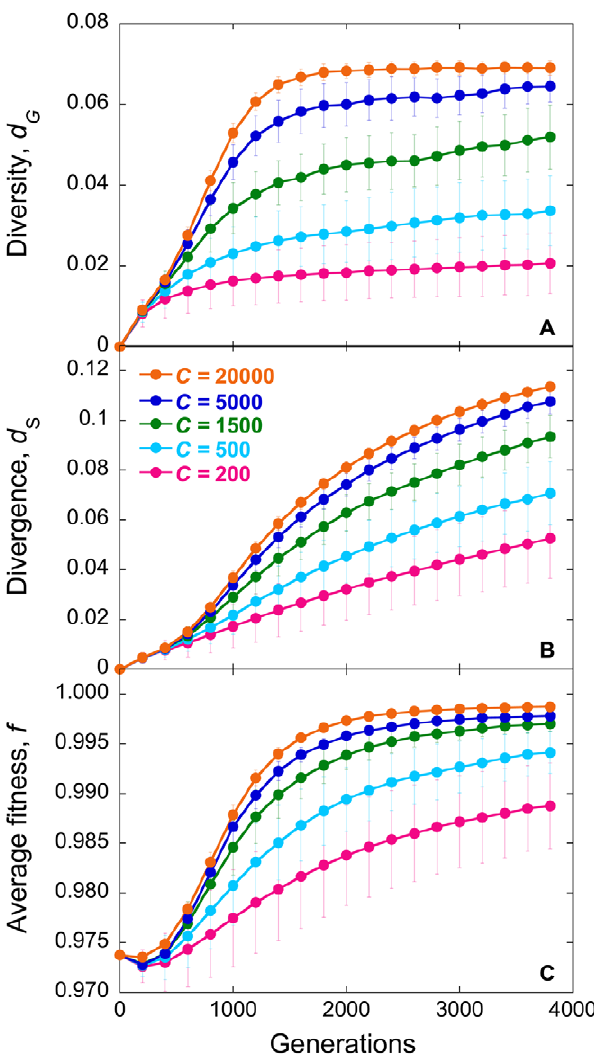
Figure 1. Simulations of viral genomic diversification. The evolution of (A) viral diversity, d G , (B) divergence, d S , and (C) average fitness, f , with generations predicted by our simulations for different population sizes, C . Each cell is assumed to be infected with M =3 virions. Error bars represent standard deviations.